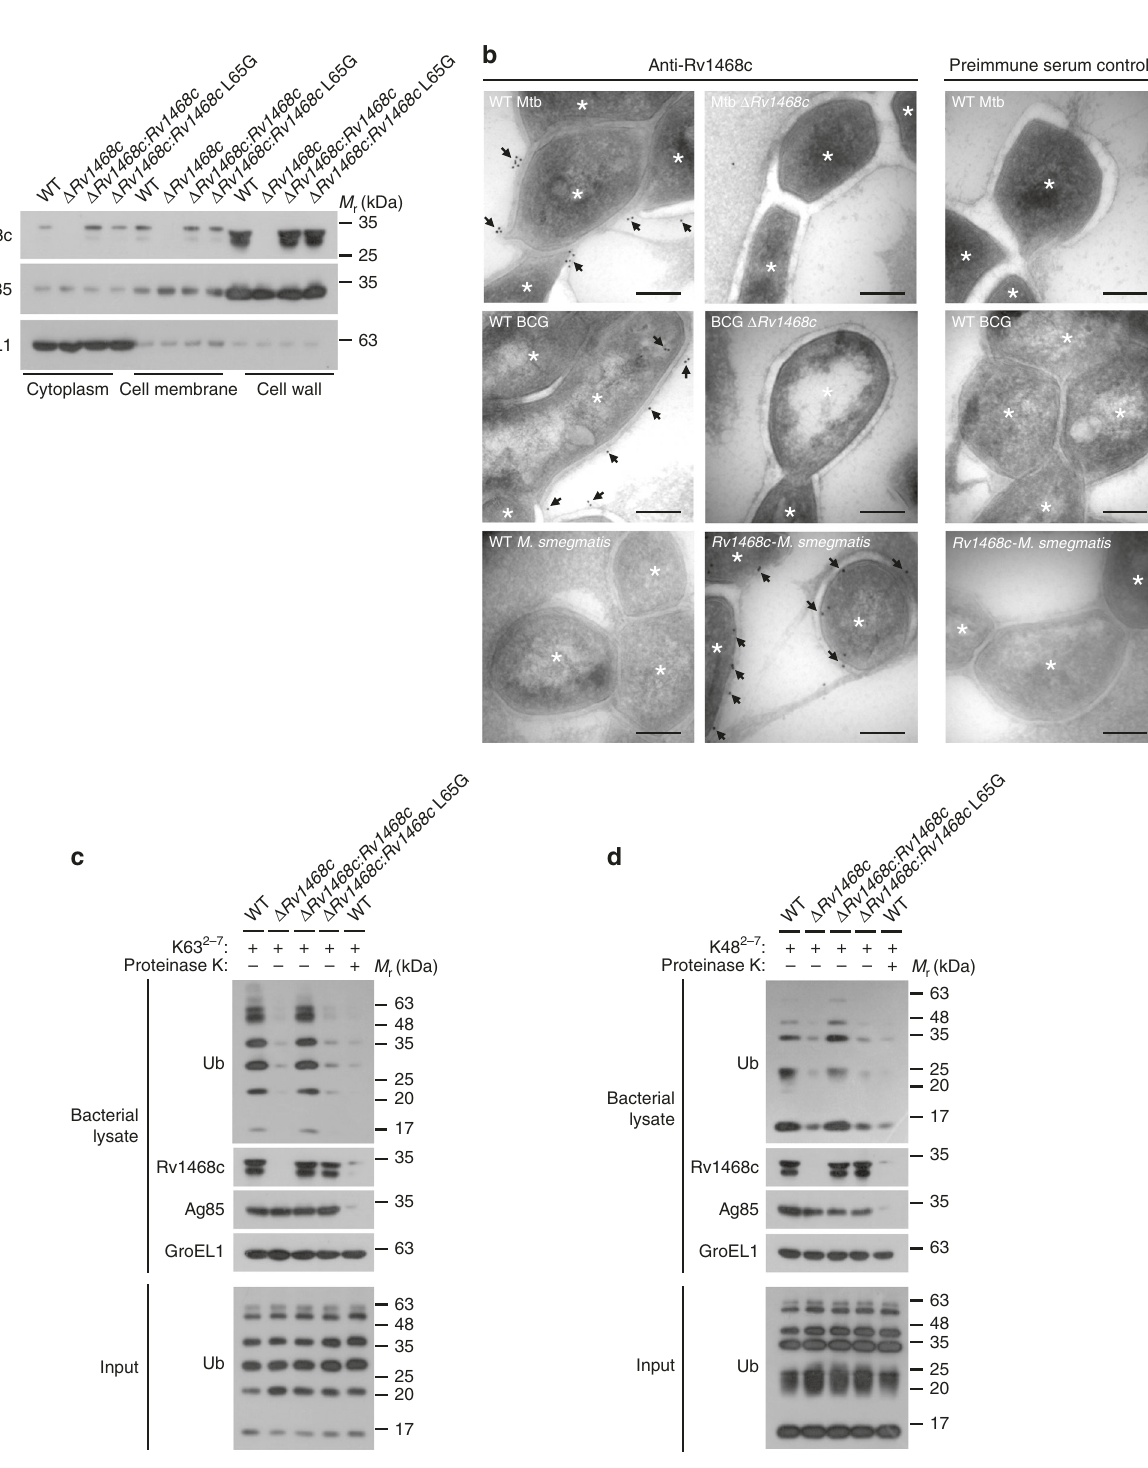
Fig. 2 Rv1468c expresses on mycobacterial surface and mediates Ub binding to Mtb. a Immunoblot analysis of Rv1468c in subcellular fractions of the indicated Mtb strains. b Electron microscopy analysis for localization of Rv1468c immunolabelled with 10 nm gold (black arrows) on ultrathin sections of the mycobacterial strains as indicated. Staining controls for anti-Rv1468c were done with preimmune serum. Asterisks represent the mycobacterial cells. Scale bars, 100 nm. c , d Immunoblot analysis of whole bacterial lysate of the indicated Mtb strains pretreated with ( + ) or without ( – ) proteinase K followed by incubation with K63 2 – 7 ( c ) or K48 2 – 7 ( d ) poly-Ub chains ( + ) at 4 °C for 4 h. Results are representatives from at least three independent